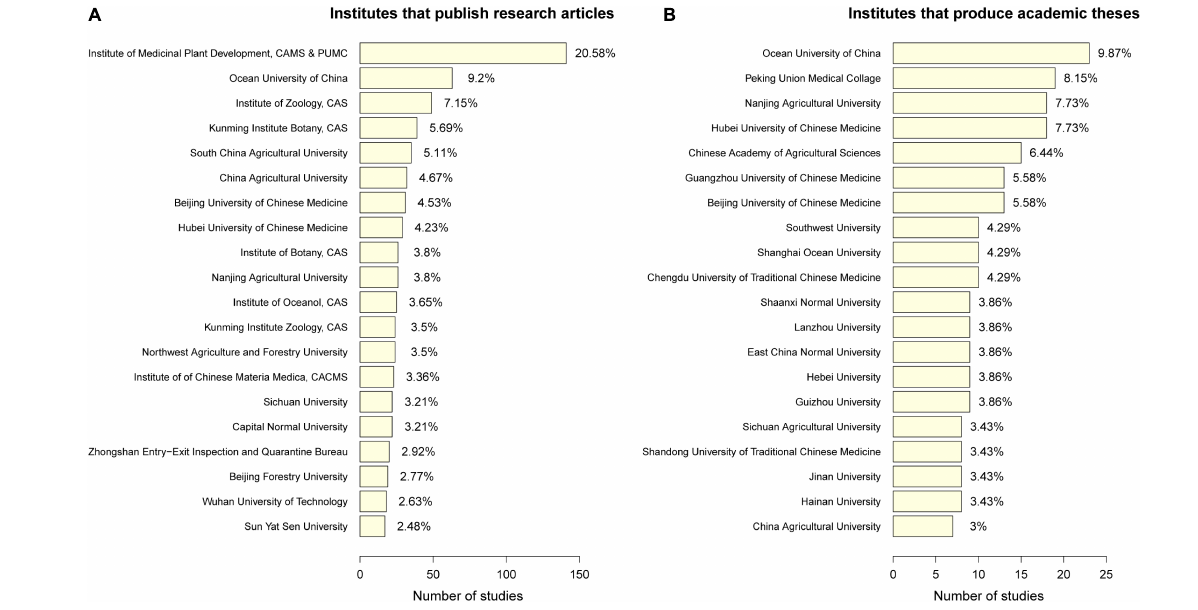
FIGURE 9 | Top 20 Chinese institutions that published (A) research articles and (B) academic dissertations in China. The X axis represents the number of studies, and the Y axis represents the name of the institution. The abbreviations are as follows: CAMS & PUMC – Chinese Academy of Medical Sciences & Peking Union Medical College; CAS – Chinese Academy of Sciences; and CACMS – China Academy of Chinese Medical